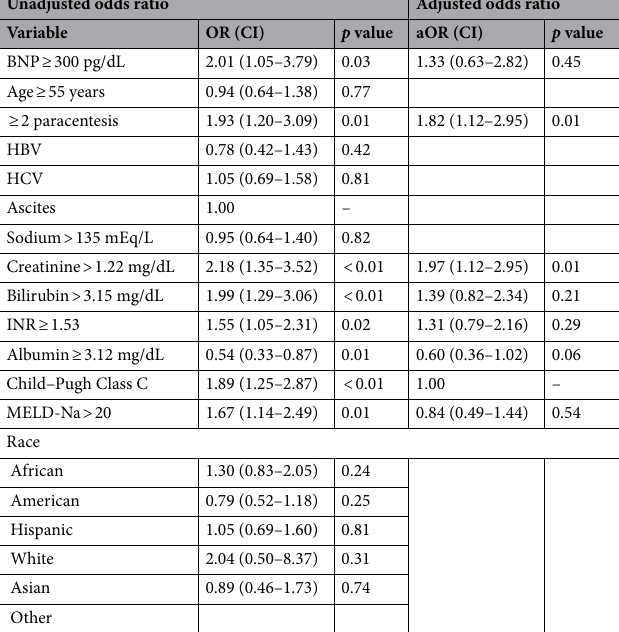
Unadjusted odds ratio Adjusted odds